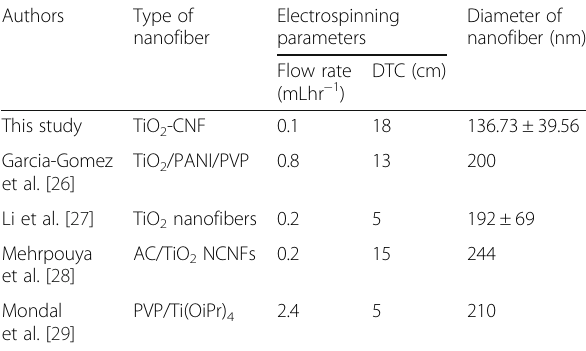
Table 3 Comparison of the nanofiber diameter with